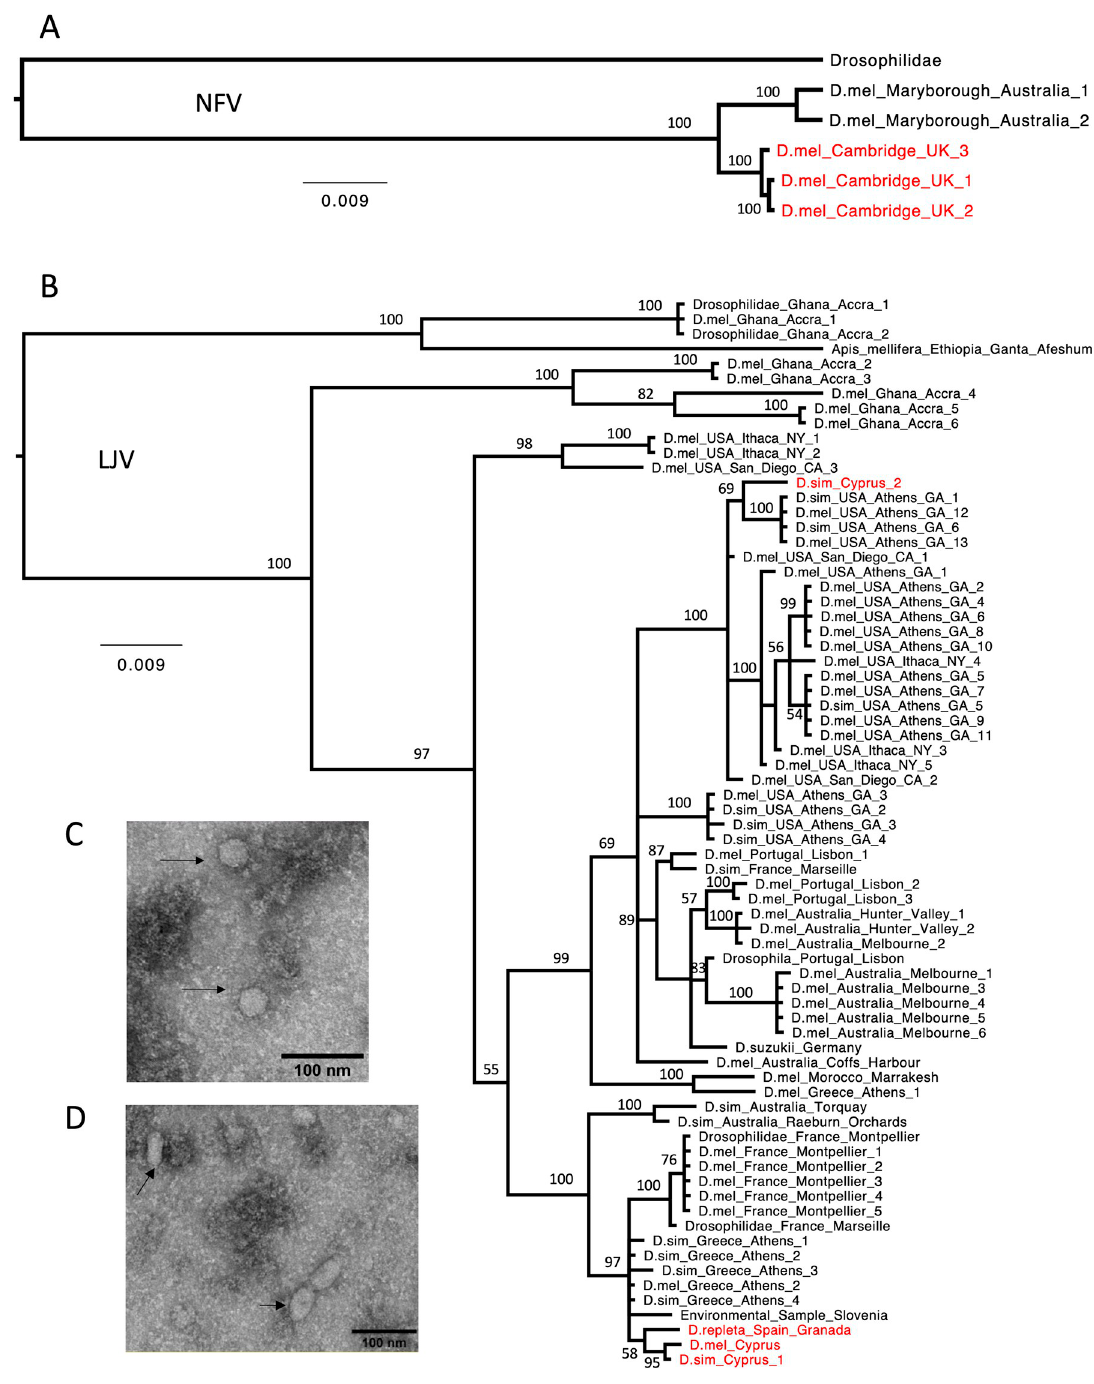
Fig 2. Phylogeny and morphology of LJV and NFV. Phylogeny was reconstructed using (A) whole-genome sequences of NFV and (B) partial sequences of the polyprotein gene of LJV. Nodes are labelled with Bayesian posterior probabilities (%) and the tree is midpoint rooted. Virus isolates from this study are red, and taxa are labelled by host species (Dmel, D . melanogaster ; Dsim, D . simulans ) and collection location. Accession numbers are in S2 Table. Electron microscopy imaging of cells infected with (C) LJV isolate GBM- 15052019-305 and (D) NFV isolate GBM-09102019-393 after negative staining. Arrows mark structures seen only in infected cells.